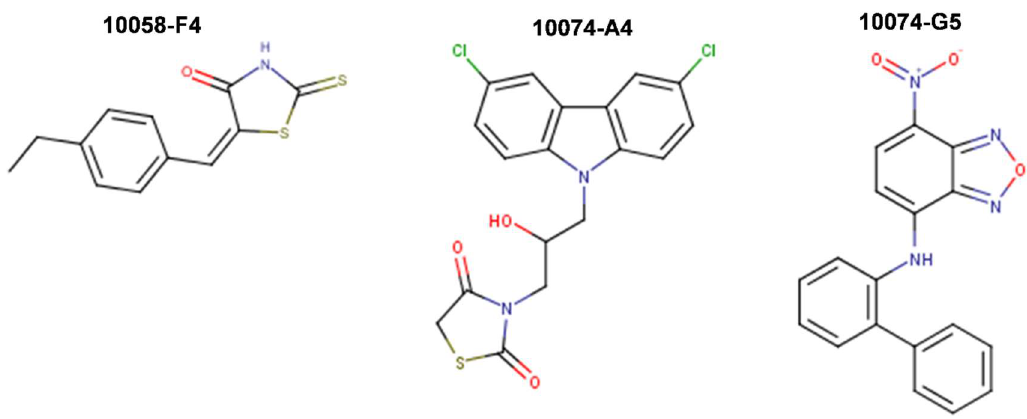
Figure 5. Chemical structures of 10058-F4, 10074-A4, and 10074-G5 inhibitors of Myc-Max dimerization identified through high-throughput screening of a finite combinatorial library. See text for details.